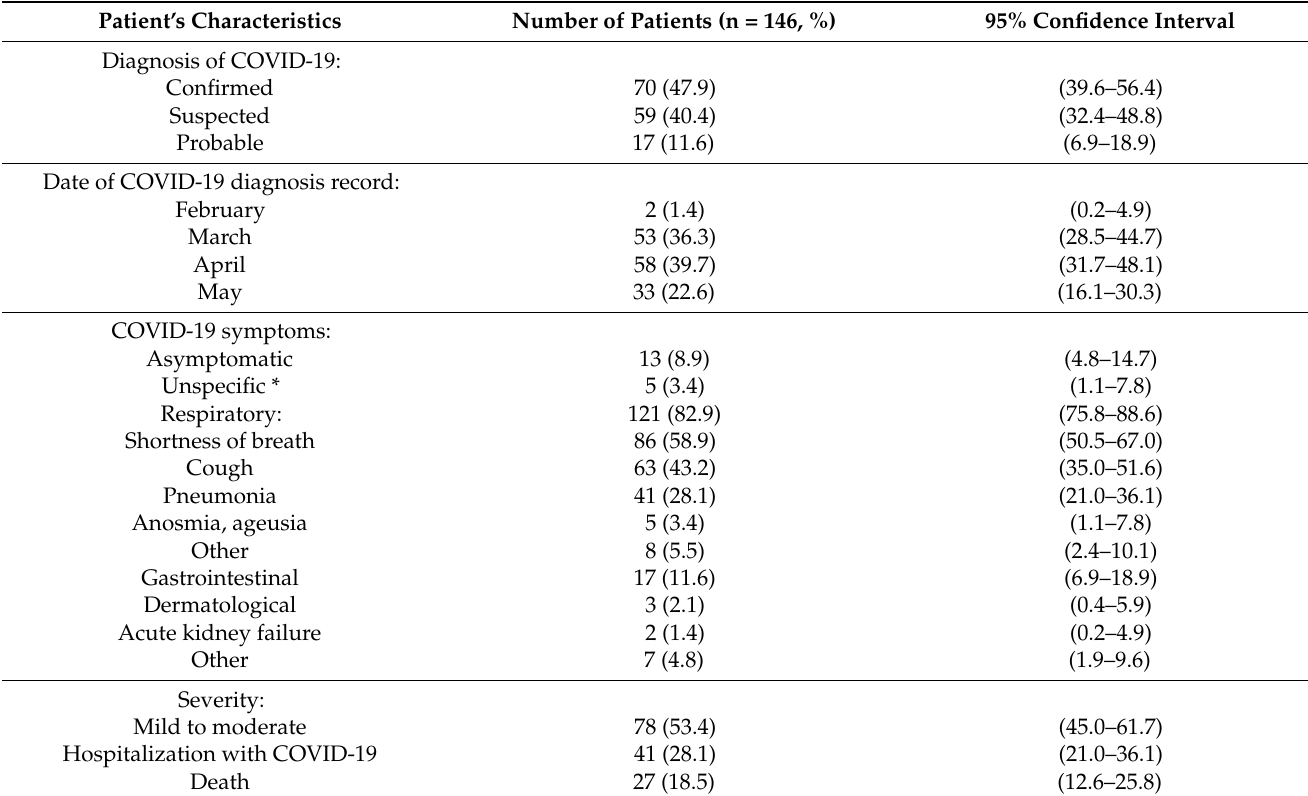
Table 3. Clinical characteristics of COVID-19